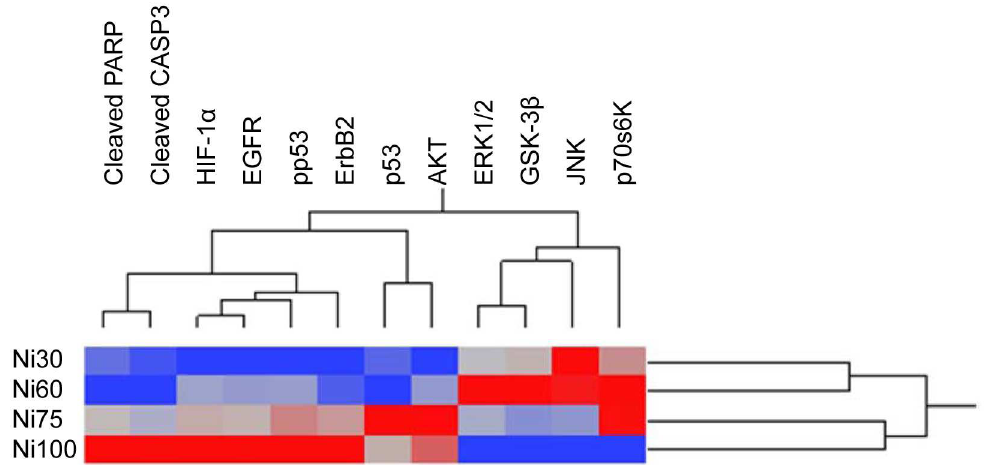
Fig 2. Hierarchical clusteringof 12 differentially expressed or phosphorylatedproteinsin BEAS-2Bcells treatedwithNi (II). Dendrogam was obtainedfromhierarchical clusteranalysiswhich is mainlybased on dynamic changes of proteins.Blue fields indicatedown-regulationand the red fields indicateup-regulationof the proteins.Proteinswith most nearlyidenticaldynamic patternand similarfunctionsare usually clusteredtogether.